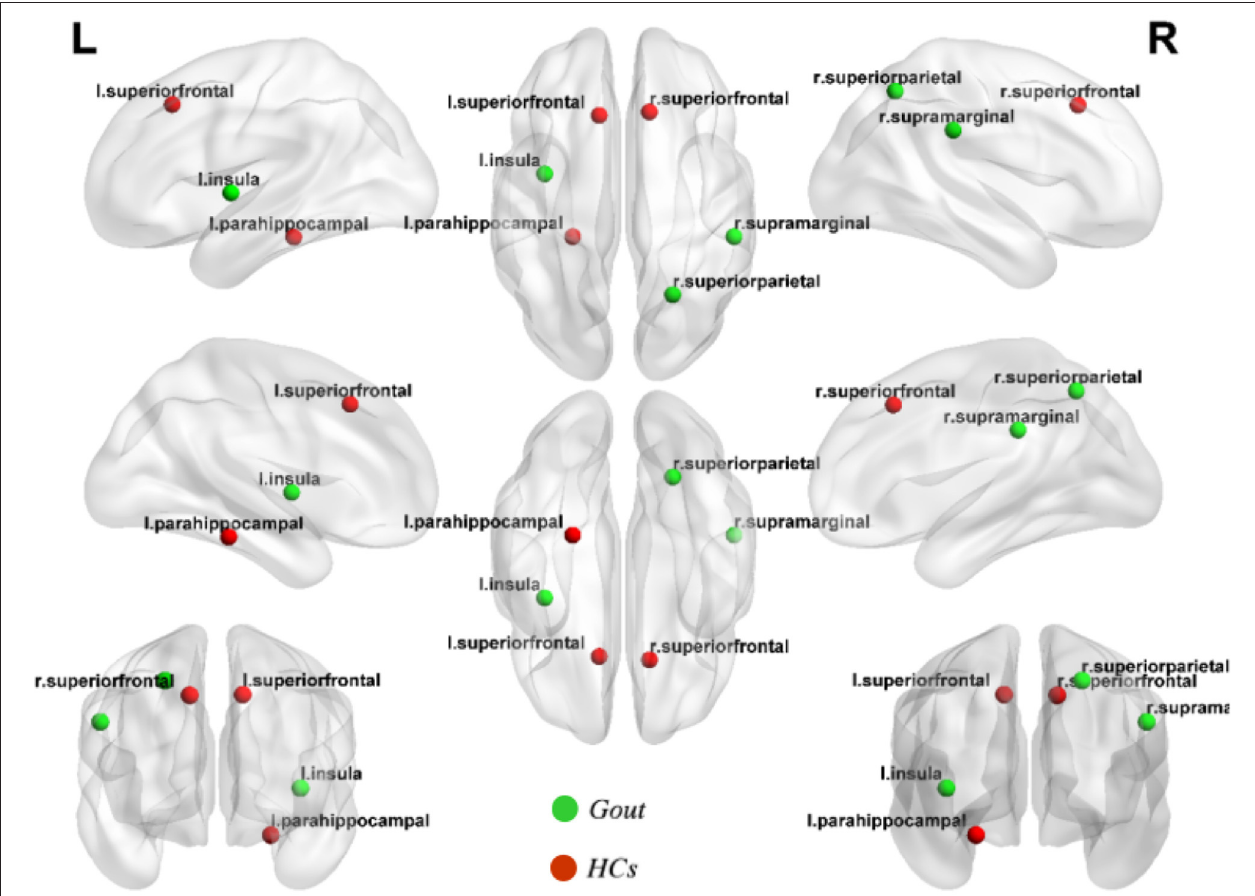
FIGURE 5 | Network hubs of the gout group and healthy control (HC) group. Three network hubs were identified in each of the gout group (green highlights) and the HC group (red highlights).